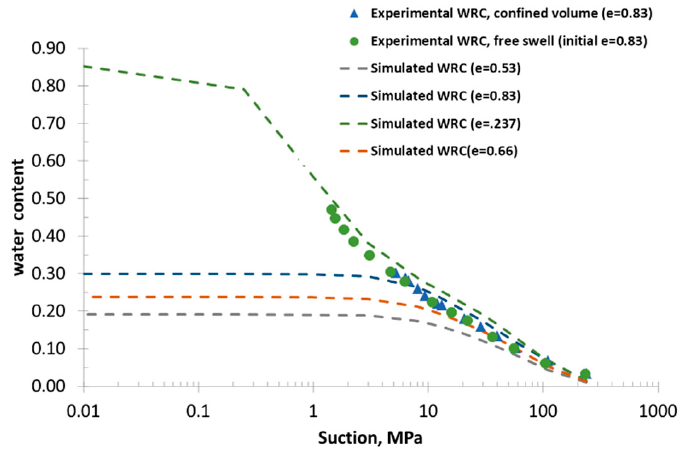
Figure 2. Experimental (data adapted from [40]) and simulated water retention curves for the modeling of the EPFL experiments with granular MX-80 bentonite.